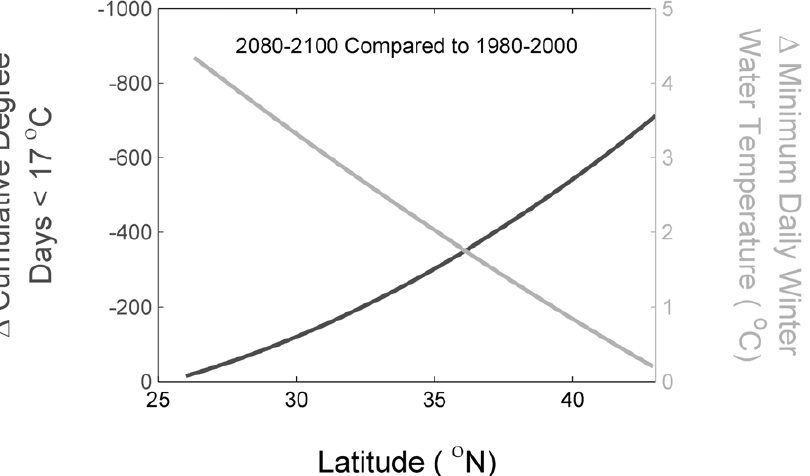
Figure 8. Change in projected cumulative degree days , 17 6 C (dark line) and change in minimum daily temperature (gray line) by latitude under the A1B scenario comparing 1980–2000 and